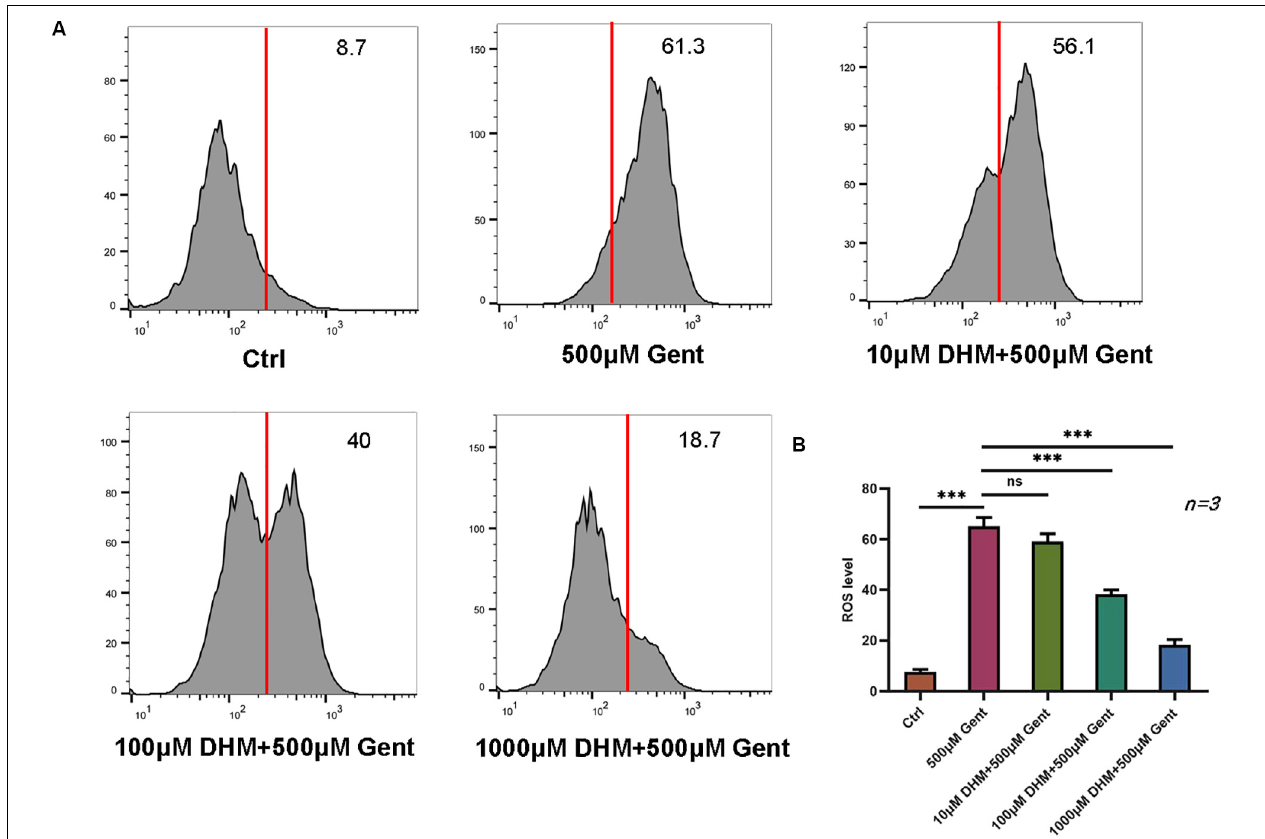
FIGURE 3 | DHM attenuates gentamicin-induced oxidative stress in HEI-OC1 cells. (A,B) HEI-OC1 cells were incubated with increasing concentrations of DHM. ROS levels after gentamicin treatment with or without DHM pretreatment were evaluated by DCFH-DA staining combined with flow cytometry. The experiment was repeated three times. NS, not significant; ∗∗∗ P < 0.001 (one-way analysis of variance followed by Tukey’s multiple comparisons test).